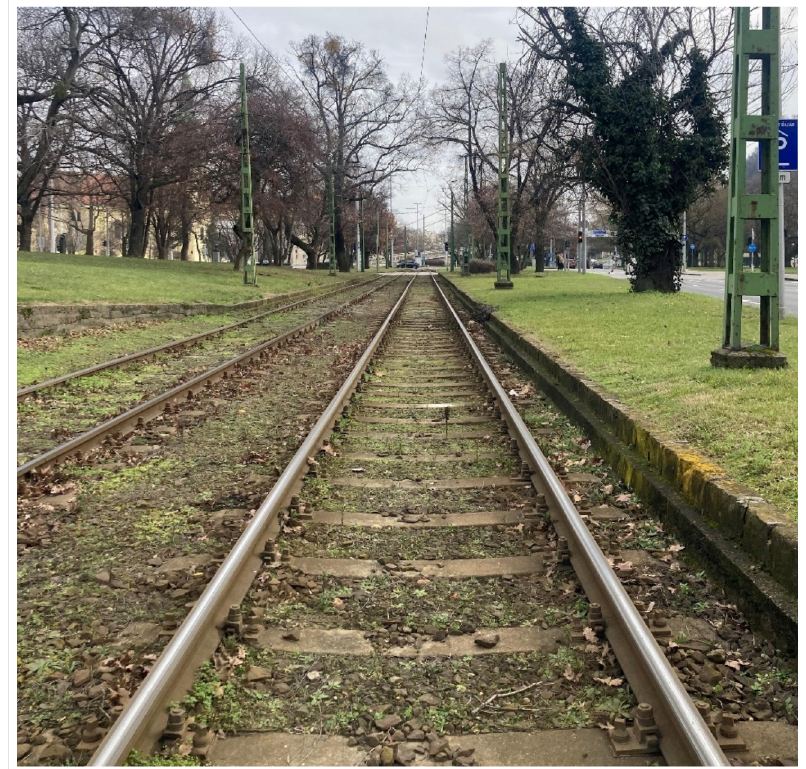
Figure 1. Photo of Section #1 (own